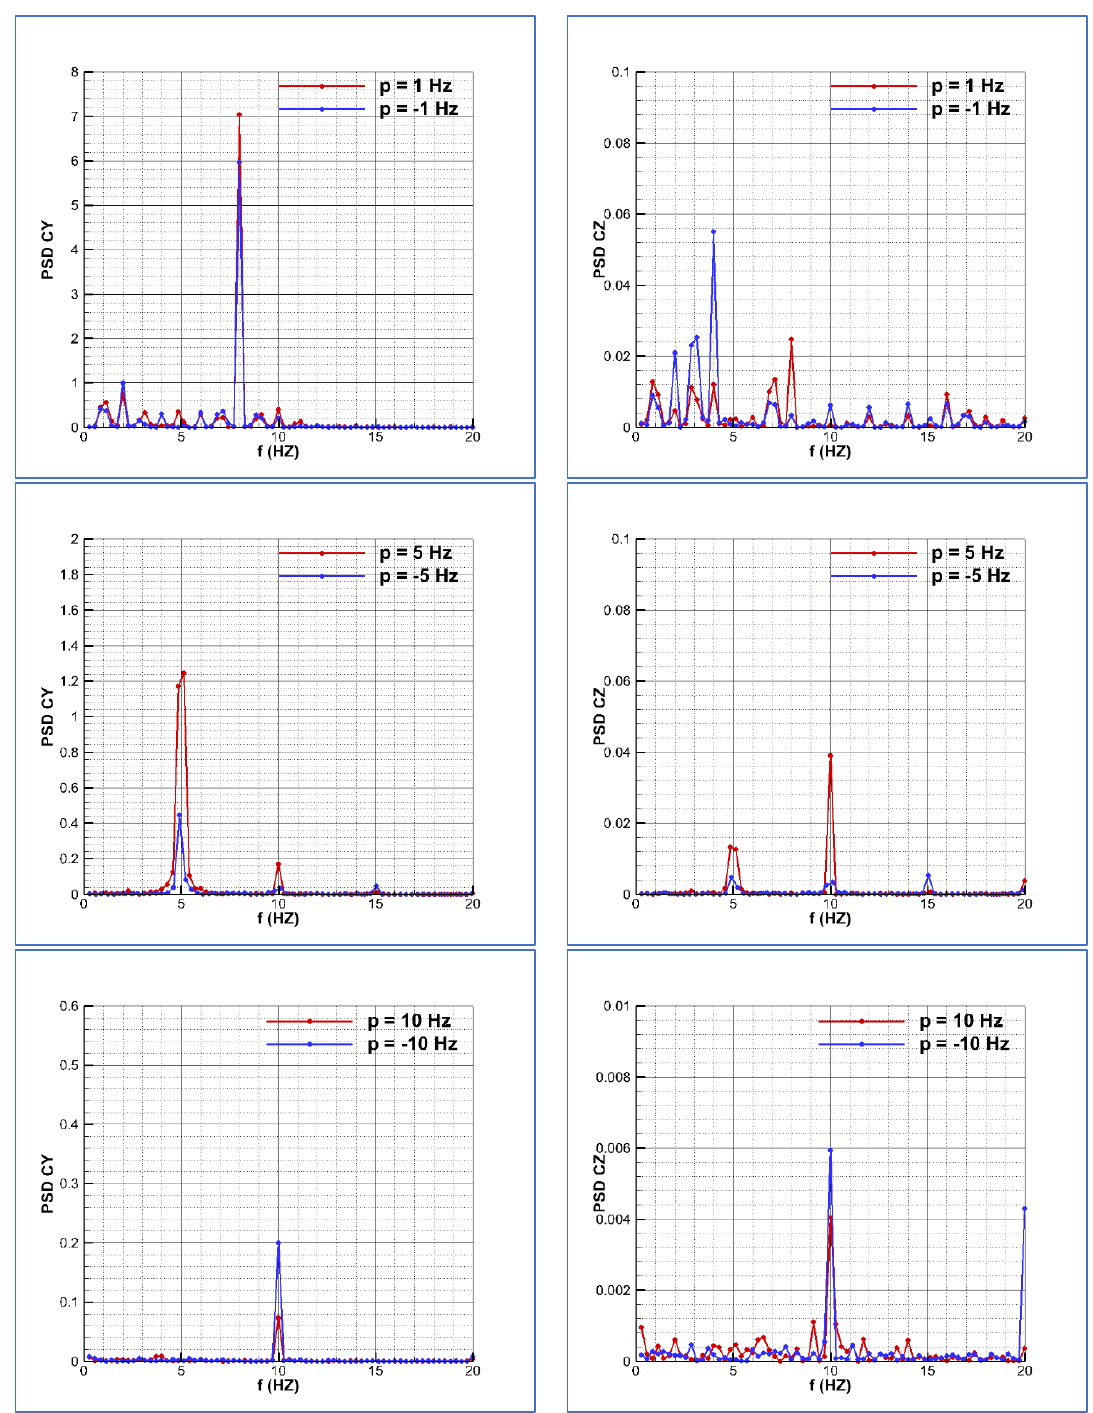
Figure 9. Power Spectral Analysis for the side ( left ) and normal ( right ) force coefficient. Ma = 0.2, Re =2 × 10 6 and α = 35 deg. Calculation with p = ±1 Hz ( above ), p = ± 5 Hz ( middle ) and p = ±10 Hz ( bottom ). Blue color: negative spin velocity. Red color: positive spin velocity.